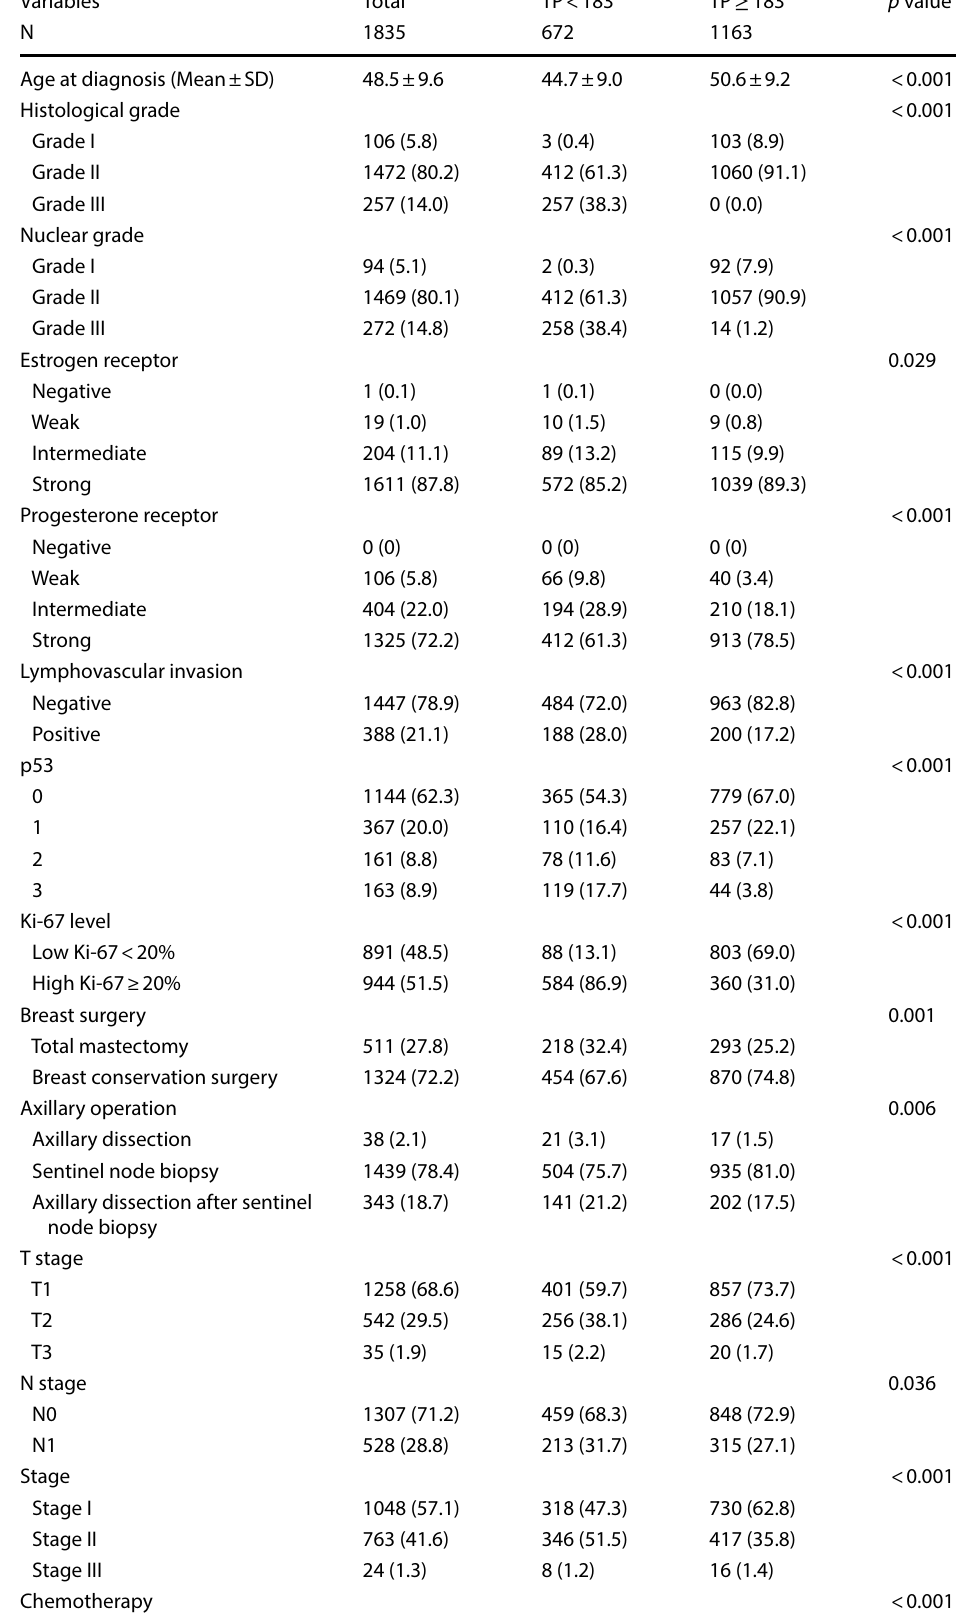
Table 2 Characteristics of the validation set 2 patient